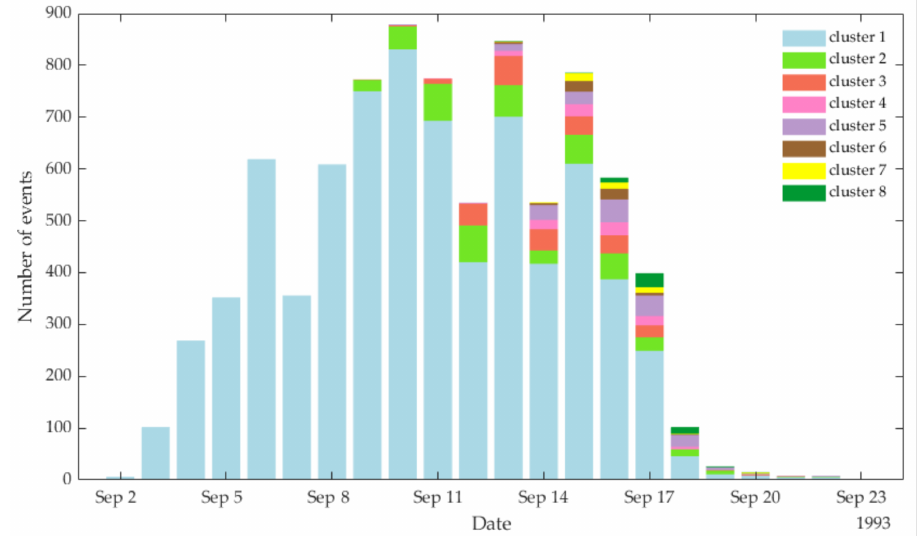
Figure 9. Daily number of seismic events divided by clusters. This bar chart shows only those events that the DBSCAN method classified into